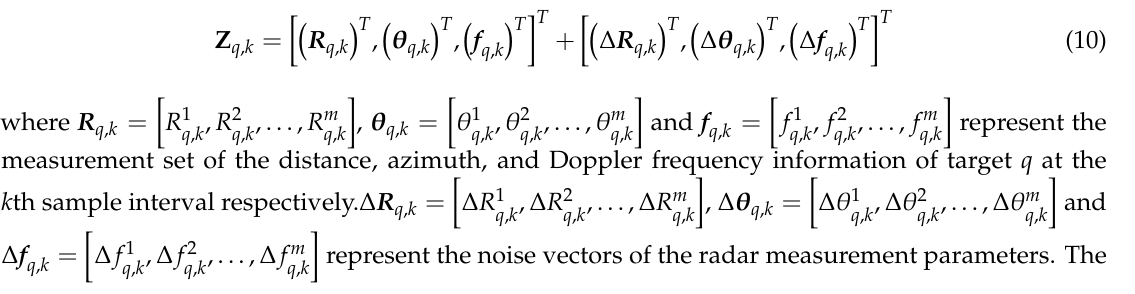
represent the noise vectors of the radar measurement parameters.